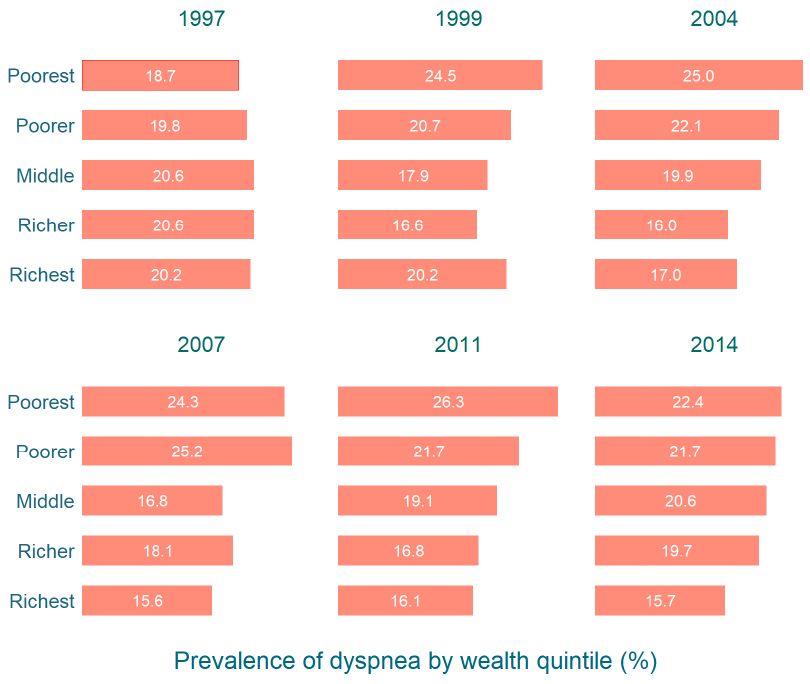
Figure 3. Prevalence of fever among under-five children by household wealth quintile in Bangladesh 1997–2014.